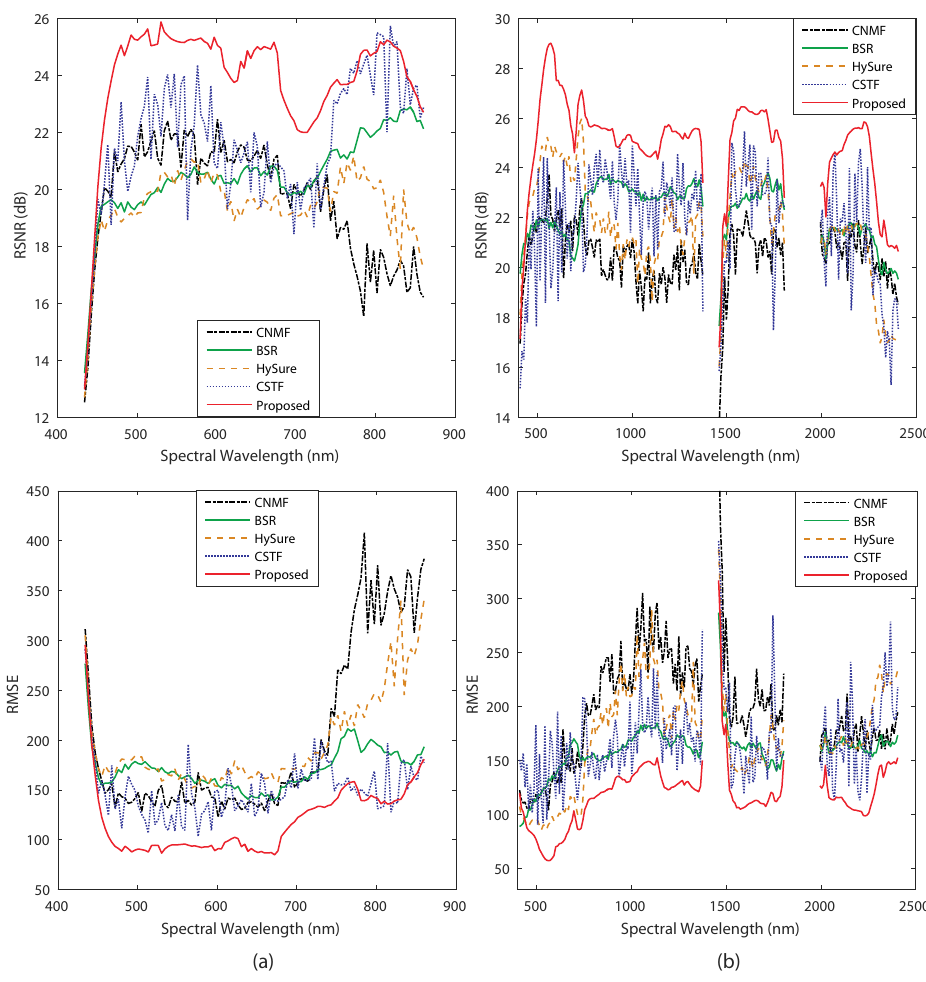
Figure 8. The performance curves of (top row) RSNR and (bottom row) RMSE w.r.t. wavelength (i.e., spectral bands), including CNMF (black dash-dotted line), BSR (green solid line), HySure (cyan dashed line), CSTF (blue dotted line) and the proposed JSMV-CNMF (red solid line) for ( a ) Pavia University and ( b ) Moffett datasets, respectively. Table 4. Complexity comparison of ADMM iterations in the proposed JSMV-CNMF algorithm for two datasets, in which the non-simplified (including Equations (17a), (17b), (21a) and (21b)) and simplified solutions (including Equations (18), (19), (22) and (23)) to various variables are compared for two